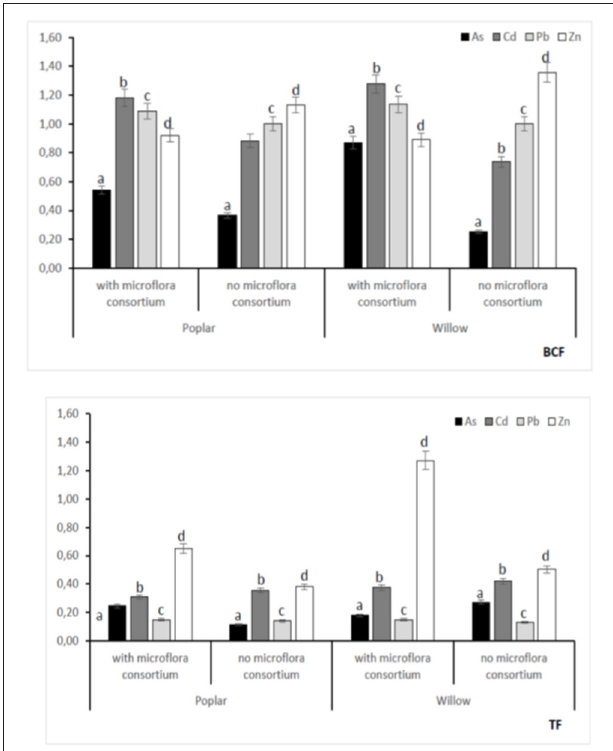
FIGURE 7 | Bioconcentraion factor (BCF) and Translocation factor (TF) at 36 months with microflora consortium and no microflora consortium in hybrid Populous deltoids × Populous nigra and in willow Salix purpurea subsp. lambertiana . Mean values ±